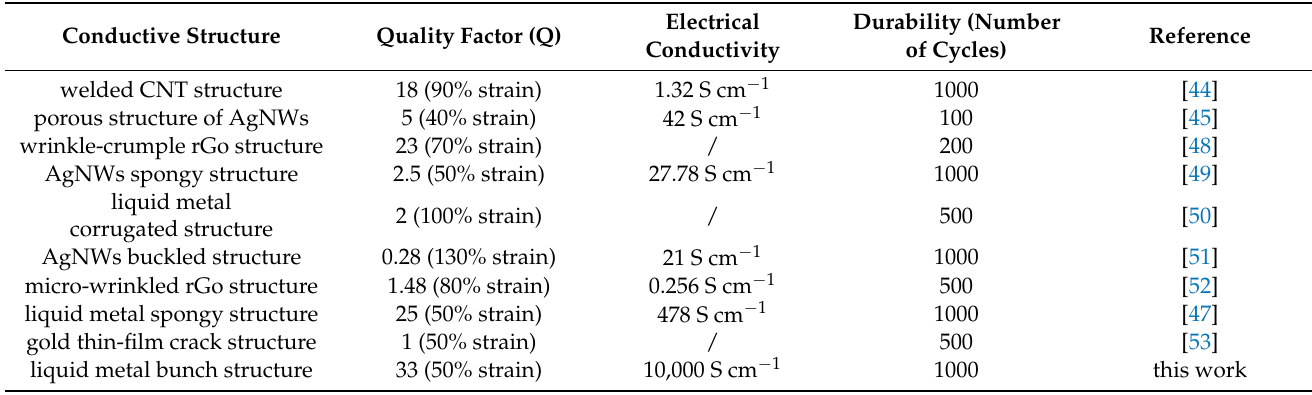
Table 1. Comparison table of equiwall-thickness bunch structure and other representative structure stretchable